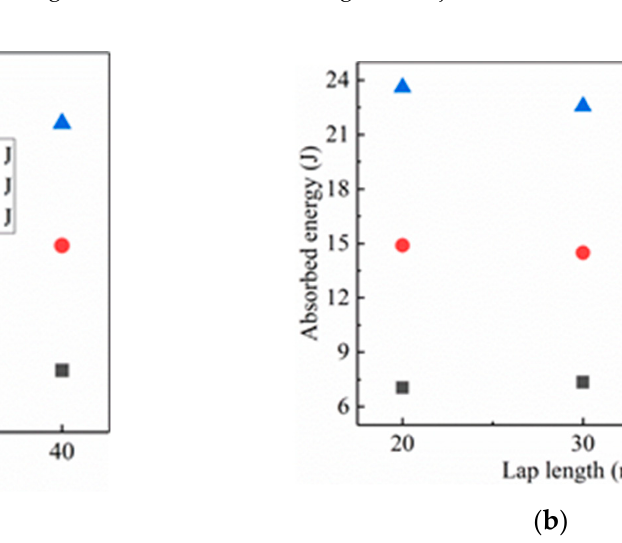
Figure 8. The influence of different overlap lengths and impact energies on the impact resistance of SLJs: ( a ) Peak force at different impact energies and ( b ) Absorbed energy at different impact energies.